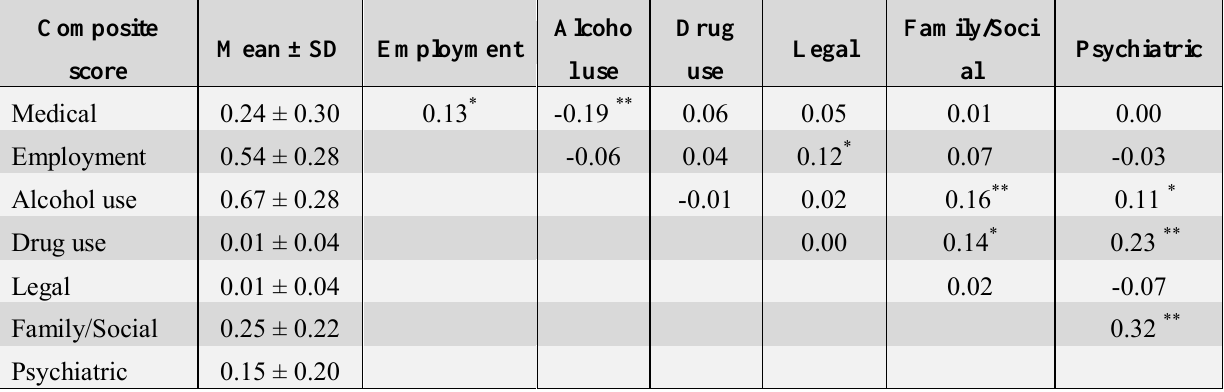
Table 1. Correlation coefficients between each ASI CS in alcohol-dependent individuals ( n =